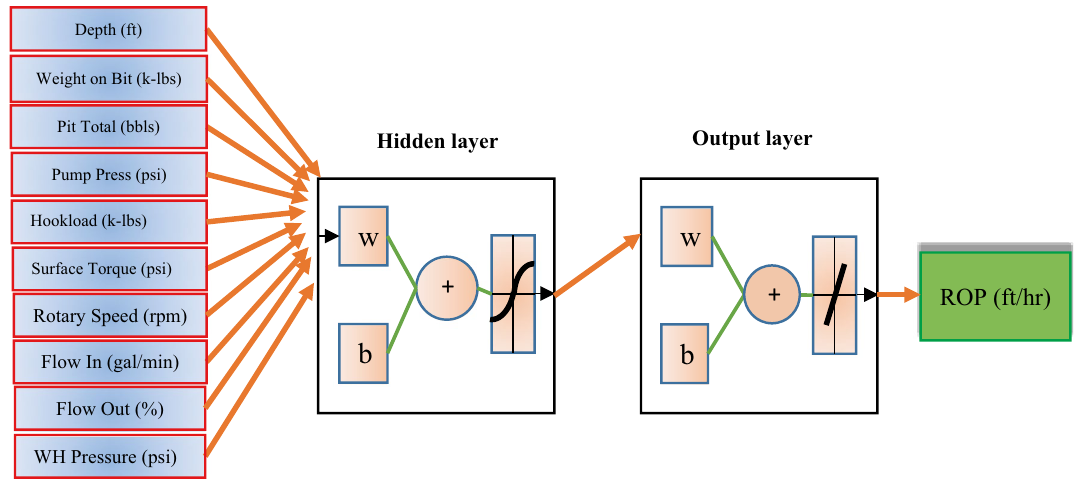
Figure 5. The schematic diagram of